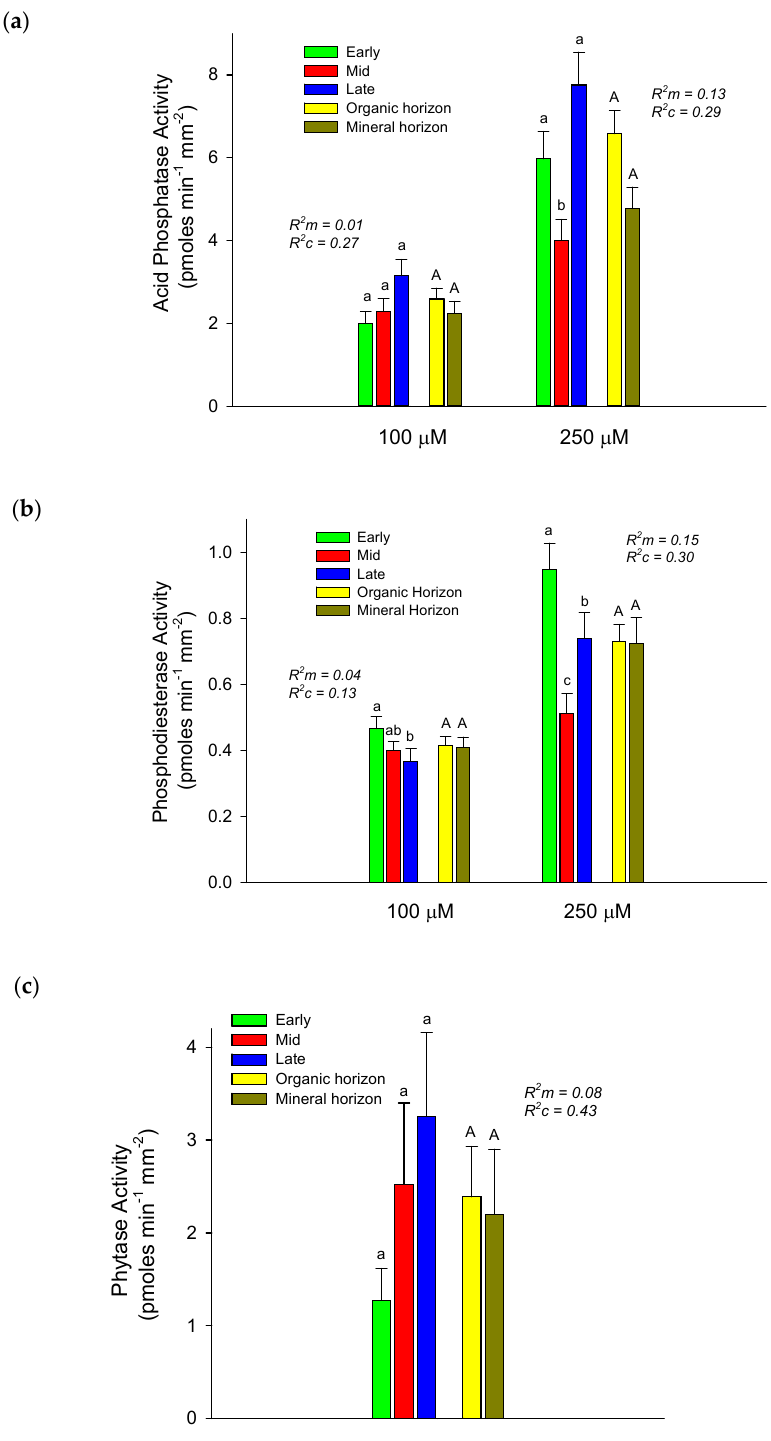
Figure 1. Mean ± S.E. activities of acid phosphatase ( a ), phosphodiesterase ( b ), and phytase ( c ) for thin-leaf alder root tips harvested from organic and mineral horizons from early, mid, and late successional stages. Different lower ‐ and upper ‐ case letters above bars indicate significant differences ( p < 0.05) between stages and horizons, respectively. Marginal ( R 2 m ) and conditional ( R 2 c ) values generated for linear mixed effects models evaluate variance explained by fixed and fixed + random effects, respectively (see Statistics section above).